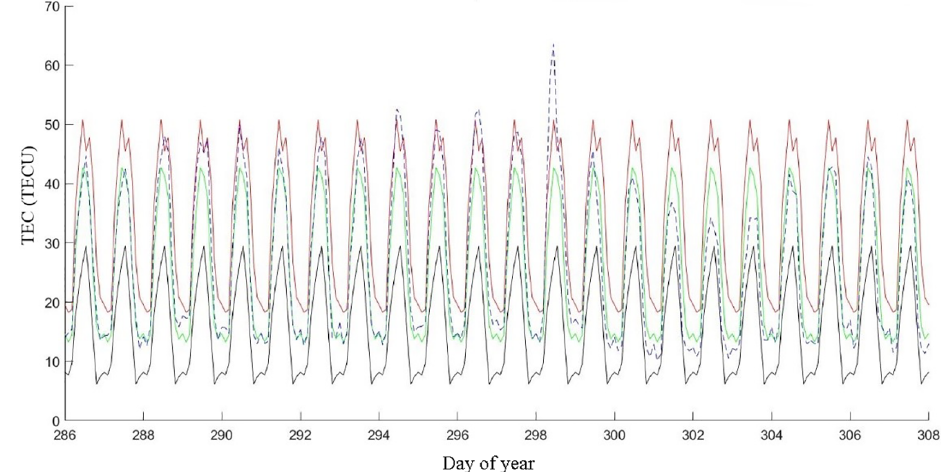
Figure 6. GIM-TEC values for AFYN Station. The black line shows lower bound TEC values, the red line demonstrates upper bound TEC values, the green line shows mean TEC values and the dotted line indicates observed TEC values for every epoch.